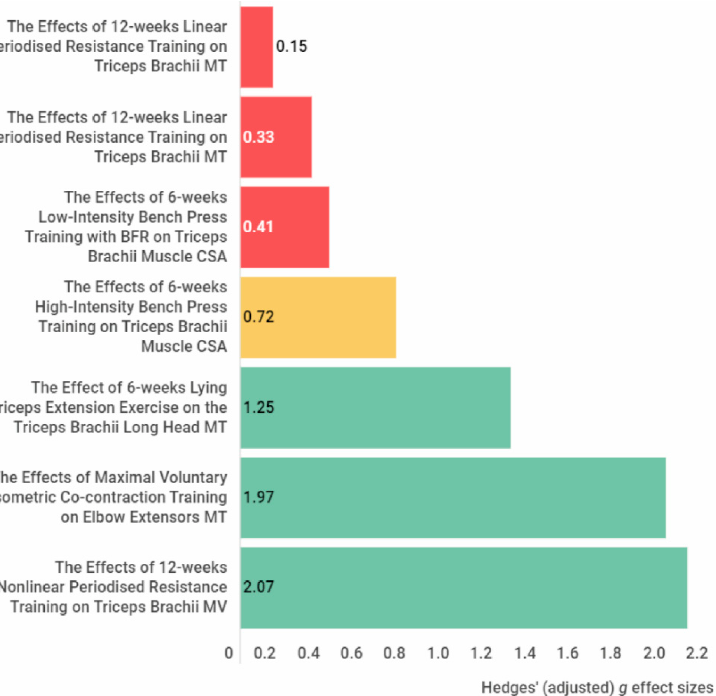
Figure 26. The effect size of the exercise interventions on the elbow extensor muscle thickness, cross-sectional muscle area and muscle volume. The red colour indicates a small or trivial effect size, the yellow colour indicates a medium effect size, and the green colour indicates a large effect size. Abbreviations: CSA, cross-sectional area; MT, muscle thickness; MV, muscle volume.